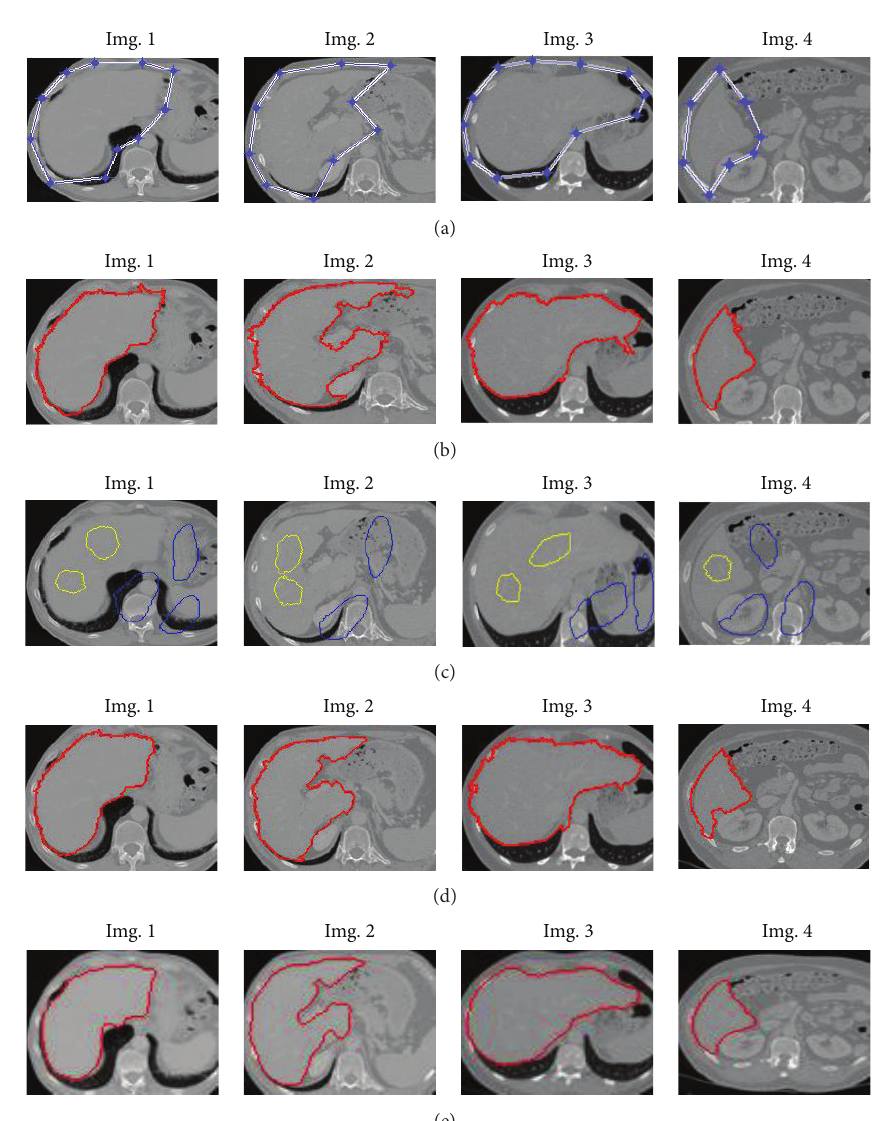
Figure 5: Comparison results. (a) Original 2D images with initial contours. (b) GCBAC. (c) Foreground initialization is in yellow and background is in blue. (d) GC. (e) The proposed